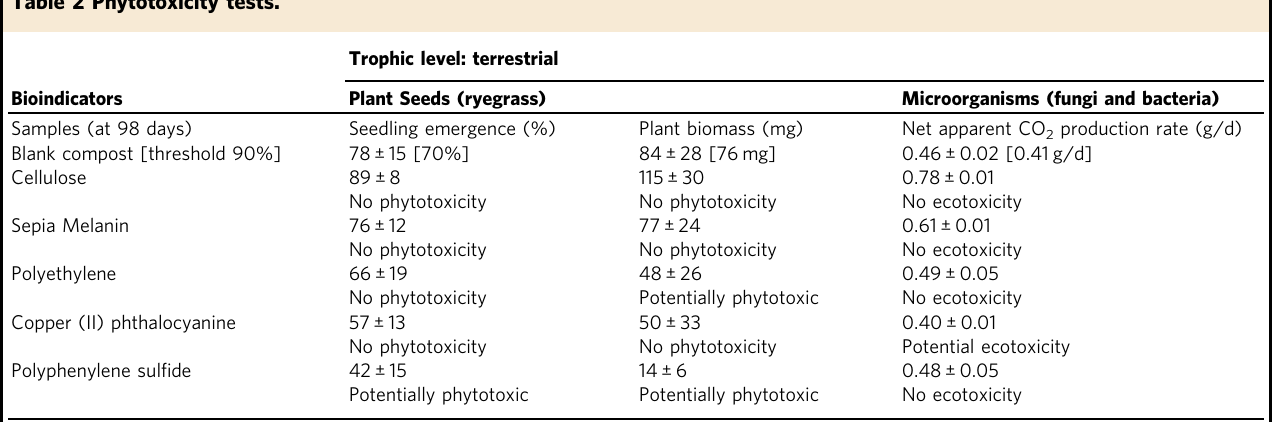
Table 2 Phytotoxicity